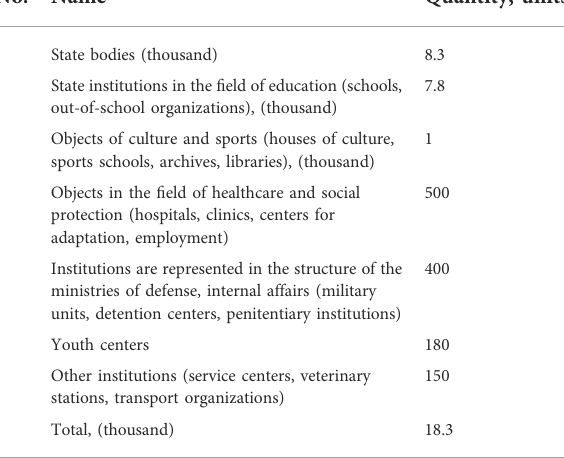
TABLE 2 Information on the number of state institutions in the Republic of Kazakhstan (for 2021).